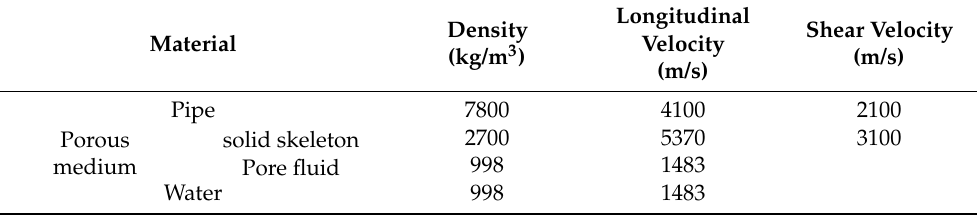
Table 1. Material properties and geometrical parameters for a case study of a liquid-filled pipe embedded in a porous medium. The pipe fluid and pore fluids are water, and the internal and external pipe radii are a = 14 mm and b = 16 mm.